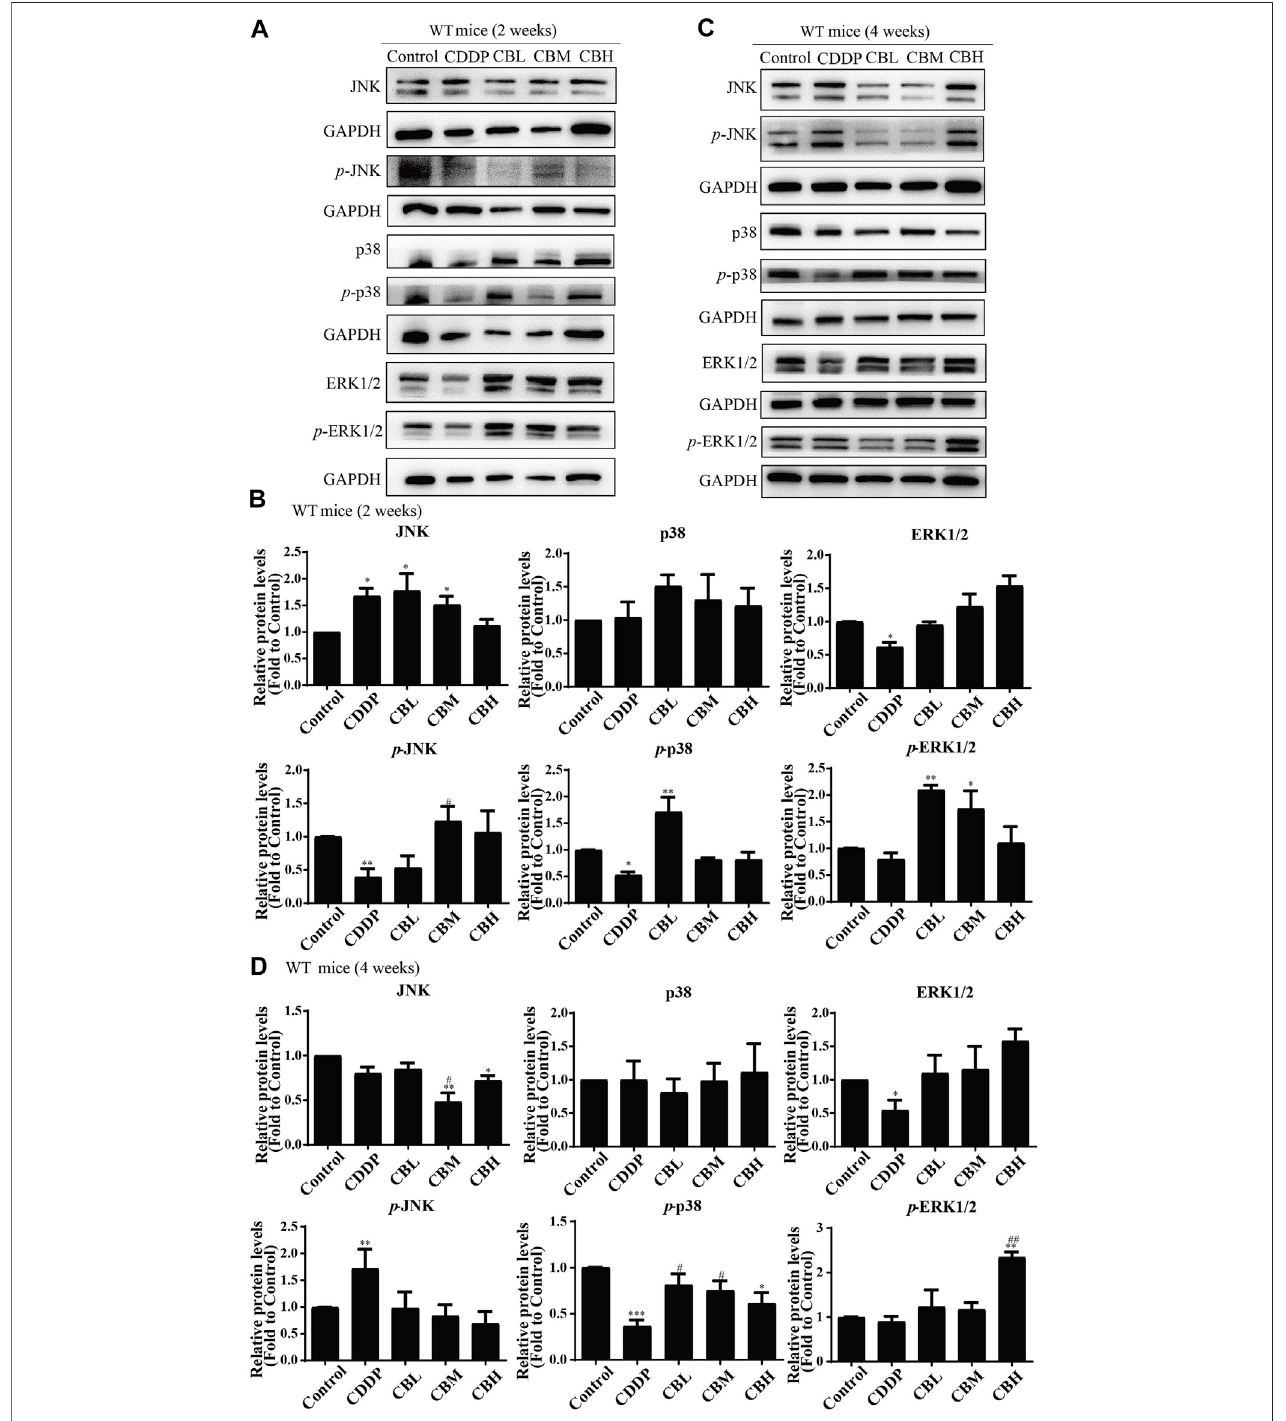
FIGURE3| BBRregulatesJNK/p38MAPKsignalingpathway. (A,B) WesternblotresultsandtheirquantitativedatashowCDDPinduced p -JNKand p -p38under- regulation in spinal DRG for 2 weeks, and BBR inhibited p -JNK and p -p38 under-expression in DRG. (C,D) Western blot results and their quantitative data show CDDP induced ERK1/2 ( F (cid:1) 2.817, p (cid:1) 0.0838) and p -p38( F (cid:1) 6.596, p (cid:1) 0.0029) under-regulation in spinal DRG for 4 weeks, and BBR inhibited ERK1/2 and p -p38 under- expression in DRG. Statistical analysis was performed using one-way ANOVA ( n (cid:1) 6, * p < 0.05, ** p < 0.01, *** p < 0.001, compared with the control group; # p < 0.05, ## p < 0.01, ### p < 0.001, compared with the CDDP group). CBL: CDDP + BBR low dose; CBM: CDDP + BBR medium dose; CBH: CDDP + BBR high dose.